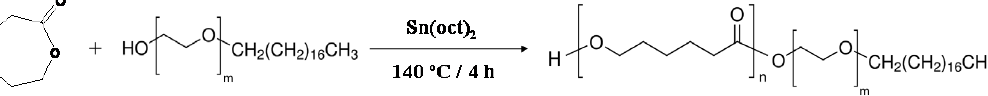
Figure 1. Synthetic scheme for Myrj- b -PCL copolymers.